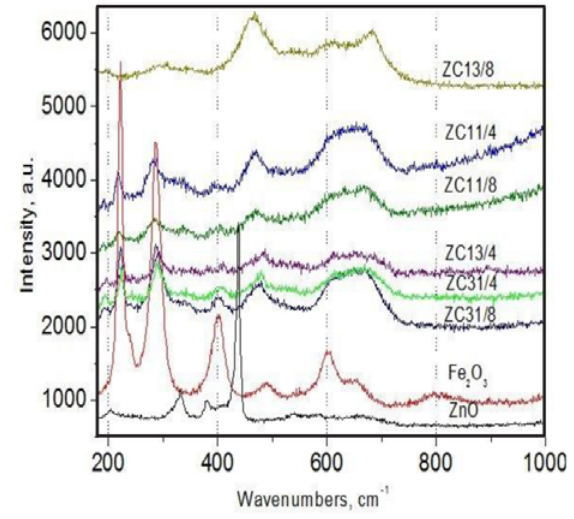
Figure 3. Raman spectra of the samples ZC31/4, ZC11/4, ZC13/4, ZC31/8, ZC11/8, ZC13/8 compared with the spectra of pure hema- tite and